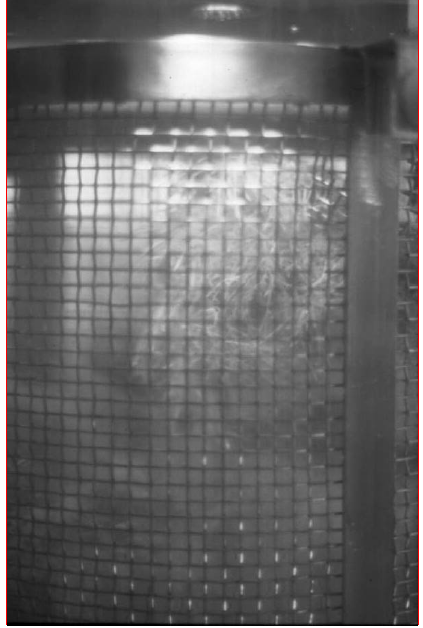
Figure 5. Detail of a hairy root culture of Duboisia hybrid showing the anchorage of the roots in the stainless mesh added to protect the culture in the stirred